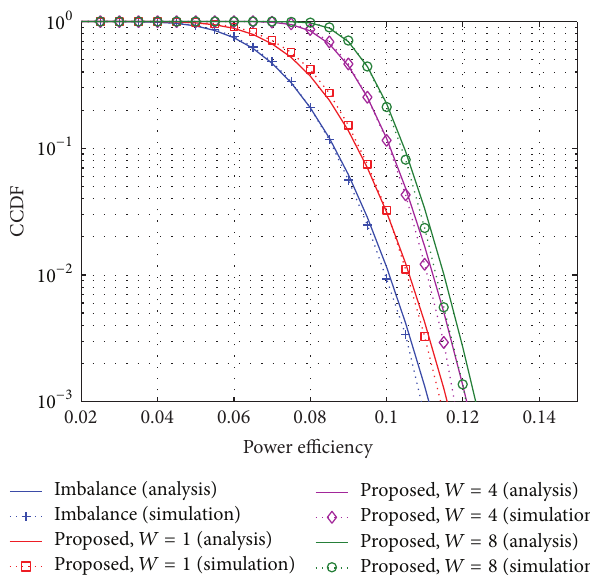
Figure 6: Comparison of CCDFs of the power efficiencies.